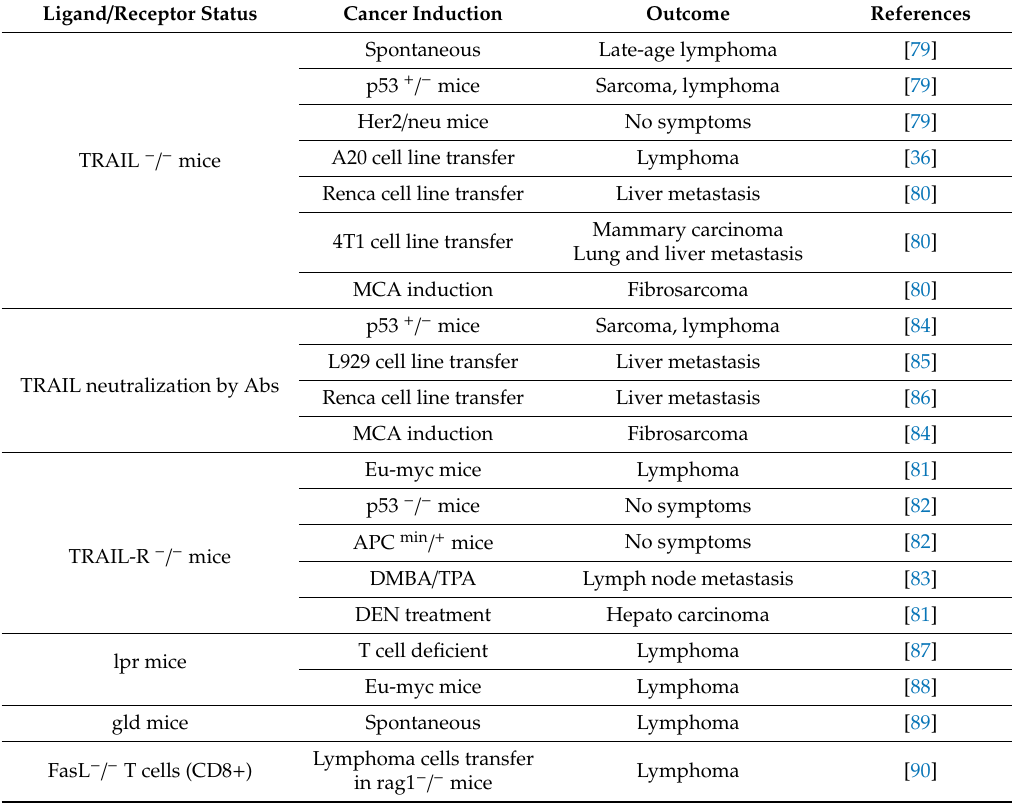
Table 2. The role of TRAIL / TRAIL-R and FasL / Fas systems in cancer development in mice models. Ligand / Receptor